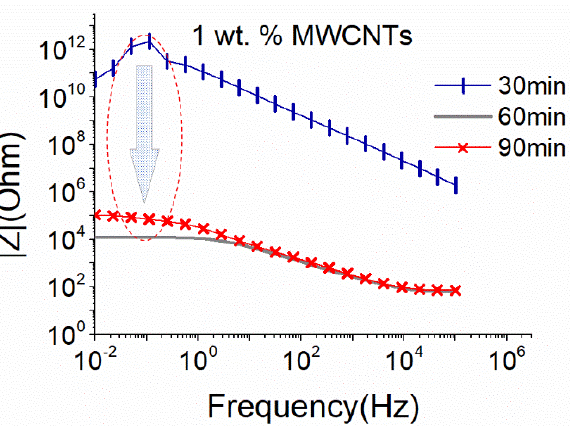
Figure 1 . EIS plots of aqueous dispersion with 1 wt.% MWCNTs using the small sonication probe at an amplitude of 50% (17.9